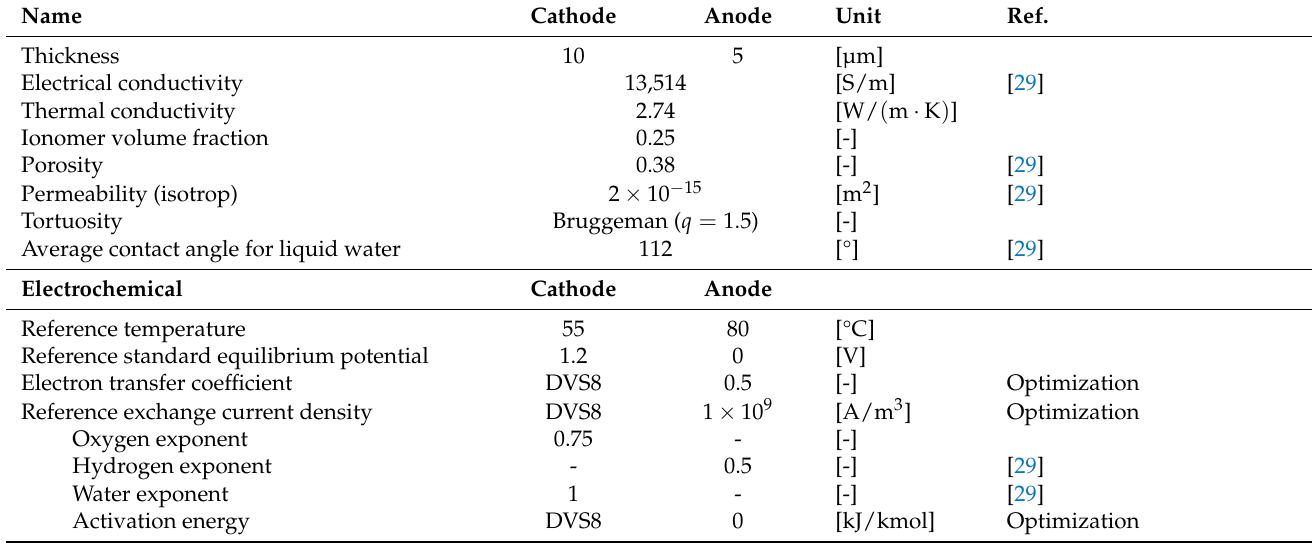
Table A2. Parameters for catalyst layers. Conductivity values are effective values.